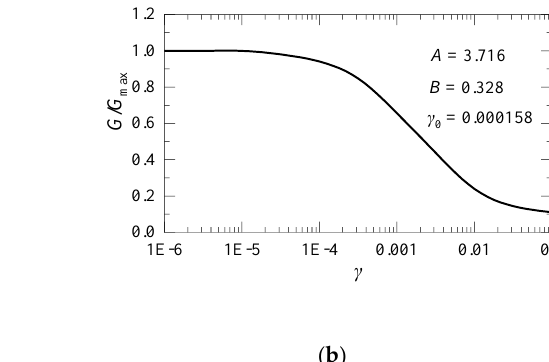
Figure 9. Cross-section of finite element model of soil.